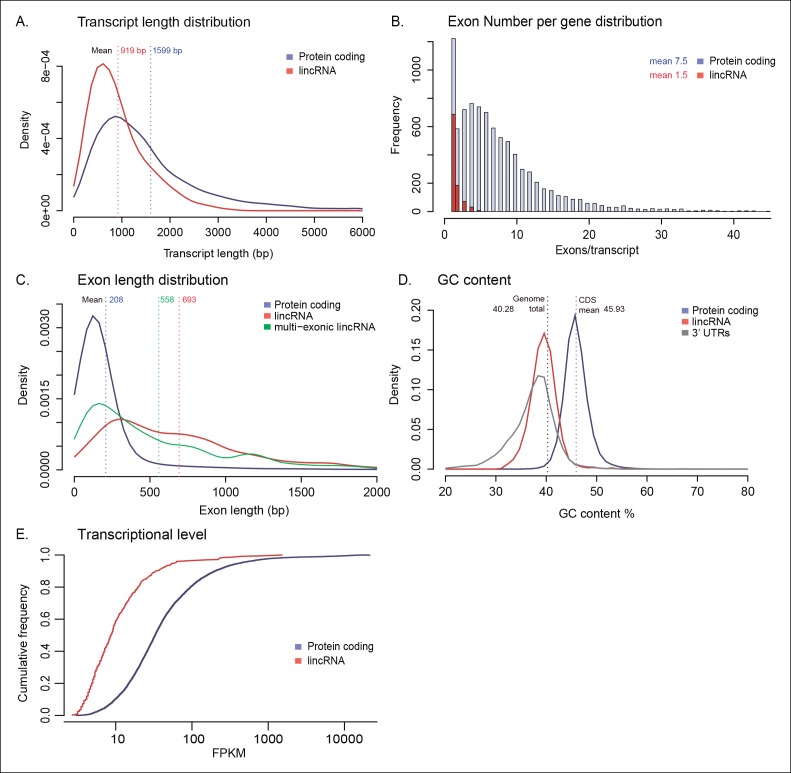
Genomic architecture of lincRNAs compared to protein-coding genes.(A) Kernel density plot showing transcript length distribution. Protein-coding genes are shown in blue, lincRNA in red. (B) Density plot showing exon number distribution. (C) Kernel density plot showing exon length distribution; multi-exonic lincRNAs are shown in green. (D) Kernel density plot showing GC content distribution. The dashed line indicates the total genome GC content. (E) Cumulative frequency plot of expression levels obtained from log10 (FPKM). FPKM, fragments per kilobase of exon per million fragments mapped; lincRNA, long intergenic non-coding RNAs.